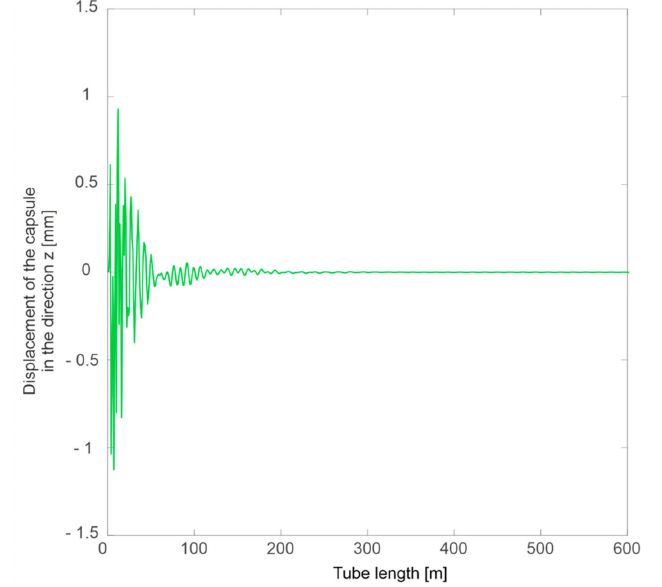
Figure 14. Lateral displacement in the direction from the capsule at a speed of 1000 km / h.